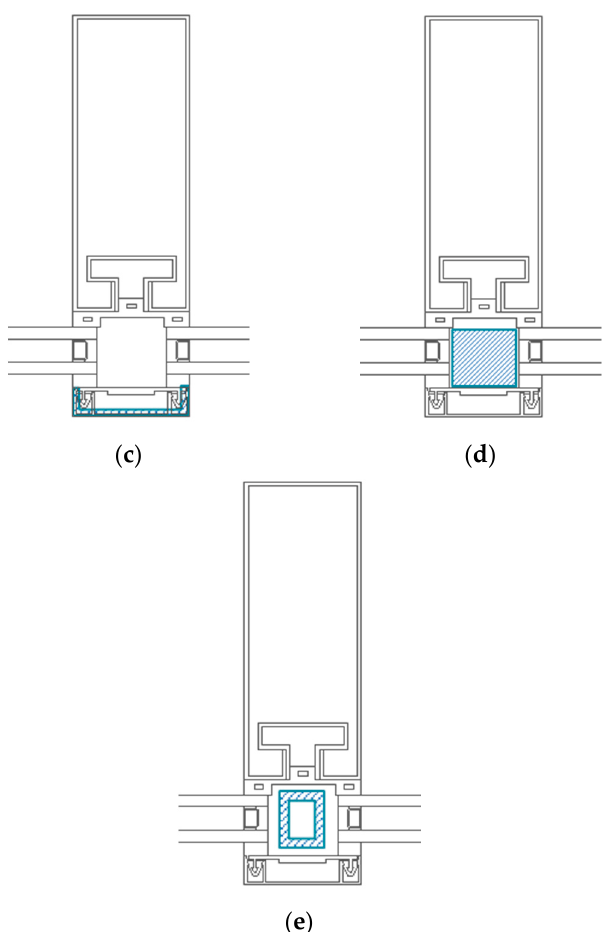
Figure 4. Technologies for improving thermal performance of steel curtain wall. ( a ) gasket; ( b ) head materials; ( c ) cover cap; ( d ) polymer infill; and ( e ) thermal break. Based on the state-of-the-art review of the technical cases, base cases and their variations were set up and drawn for more alternatives, as shown in Figure 5, to provide engineers with choices, depending on the given situation.